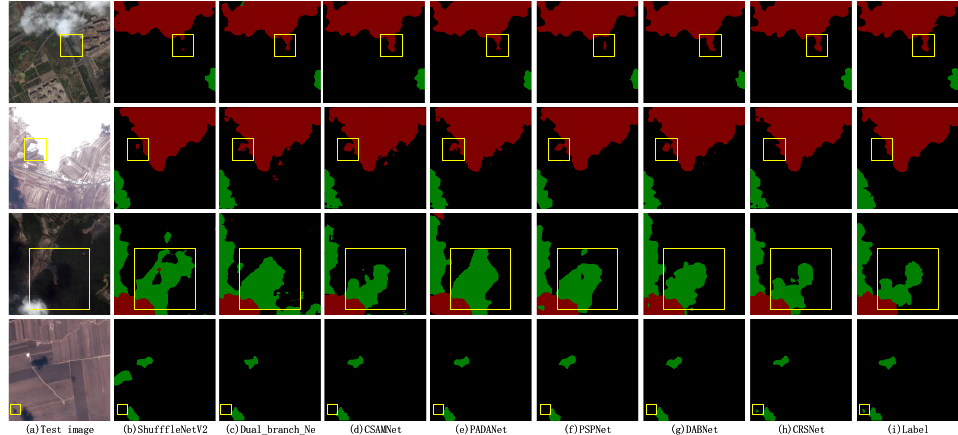
Figure 9. Prediction results of different models on Cloud and Cloud Shadow Dataset. Black, red and green represent the ground, cloud and cloud shadow, respectively. The yellow square frame marks the parts with significant differences.